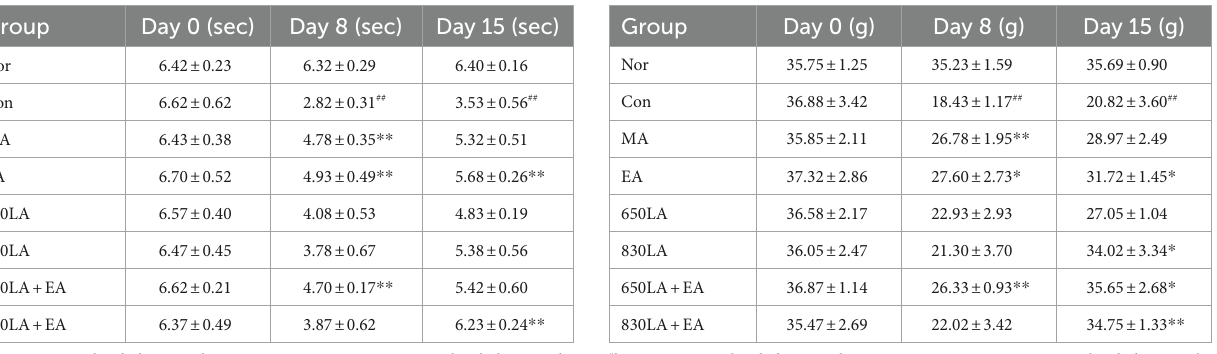
TABLE 4 Changes in von Frey force intensity in the foot of rats with paclitaxel-induced allodynia according to type of acupuncture